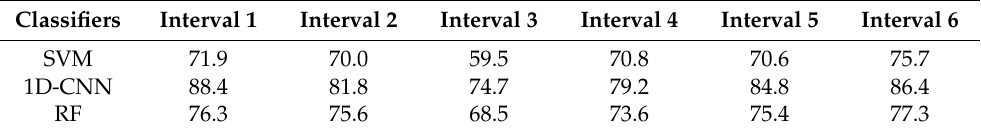
Table 1. The overall accuracy of classification results based on feature intervals.